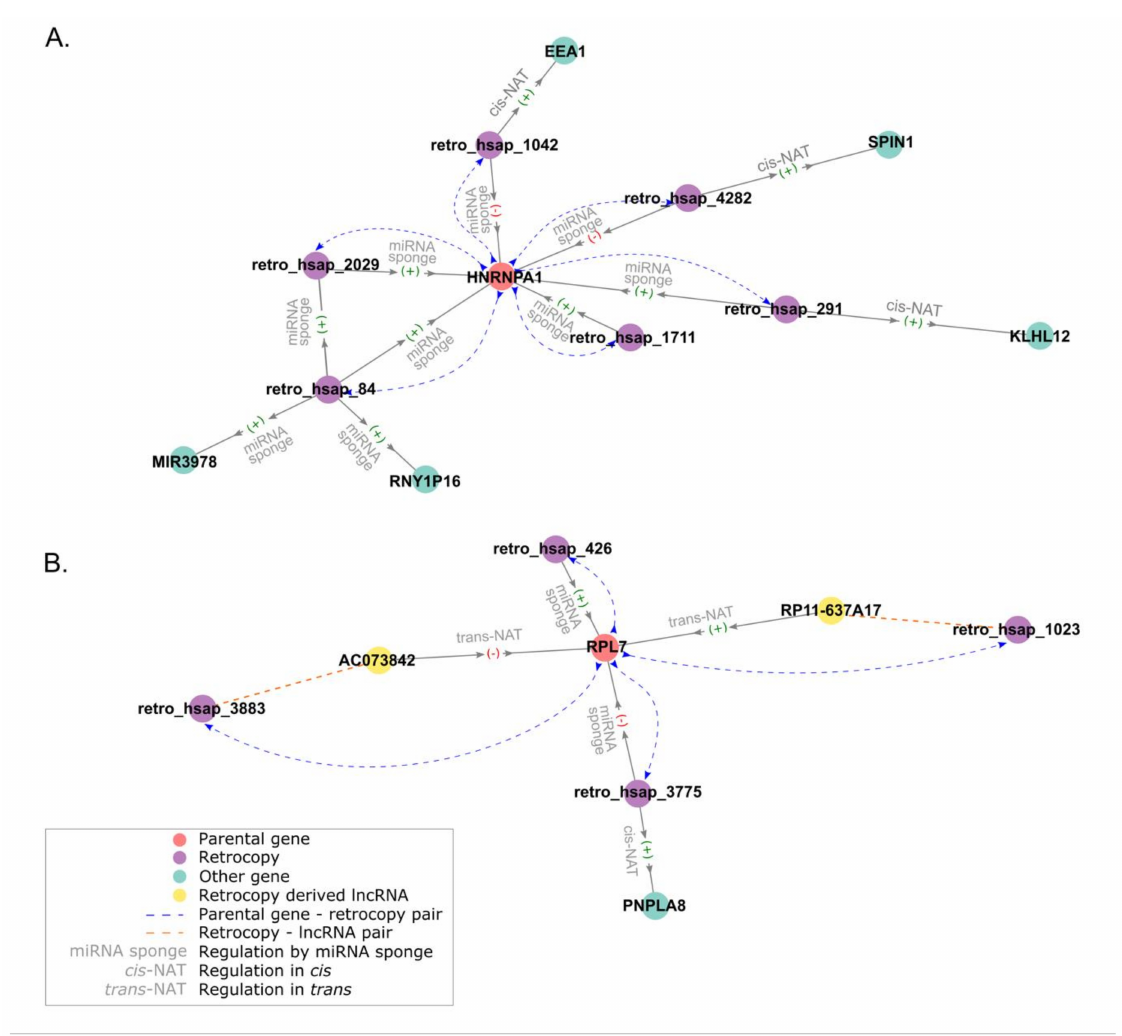
Figure 7. Hypothetical regulatory networks involving retrocopies of ( A ) gene HNRPA1 and ( B ) gene RPL7